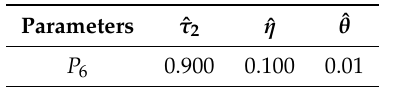
Table A10. Simulation parameters set for lag-dominant simulation (with τ 1 =